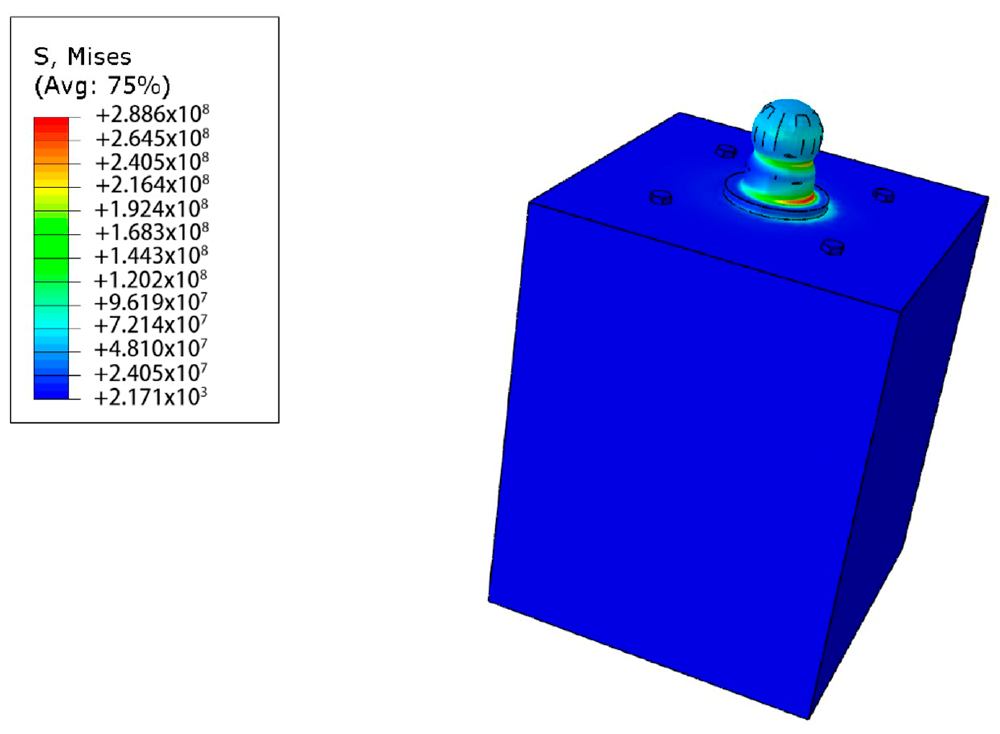
Figure 14. Equivalent stress distribution of the column support connection.